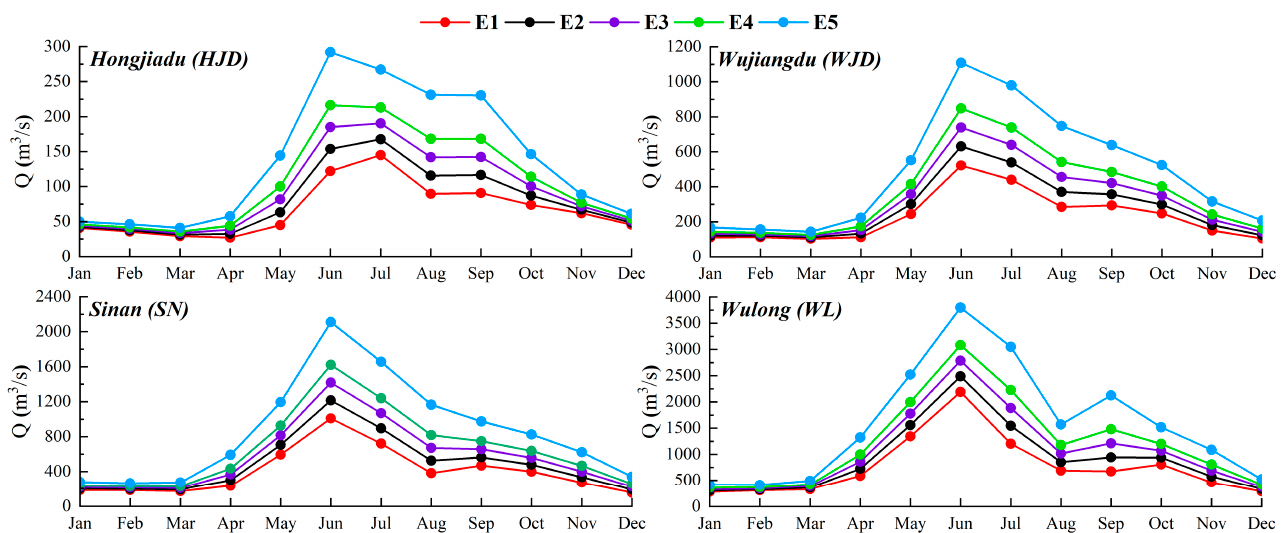
Figure 3. Multi-level environmental flow processes of Wujiang River.